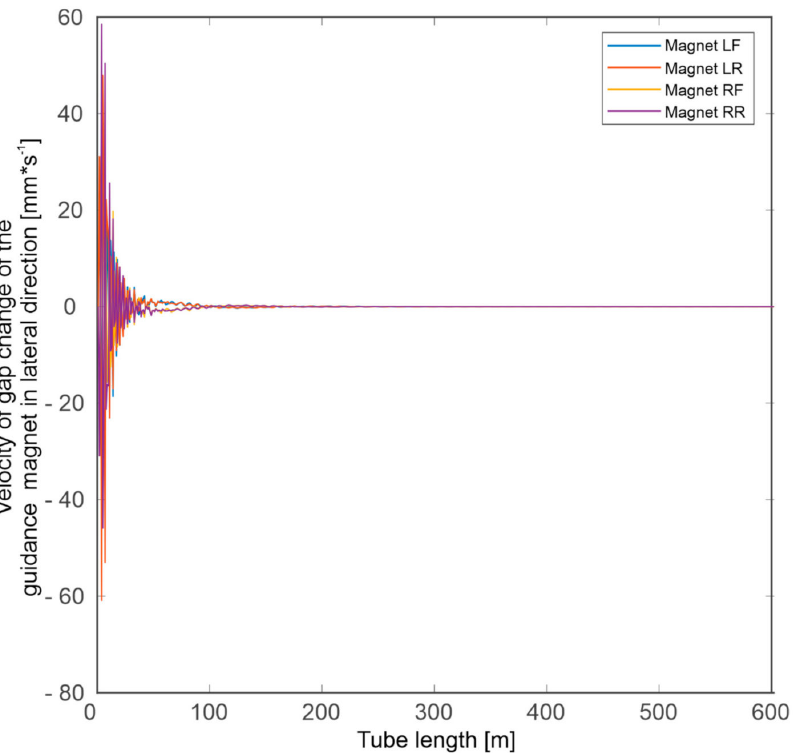
Figure 9. The speed of the gap width change on the guidance magnet in the lateral direction obtained at the capsule speed of 1000 km /